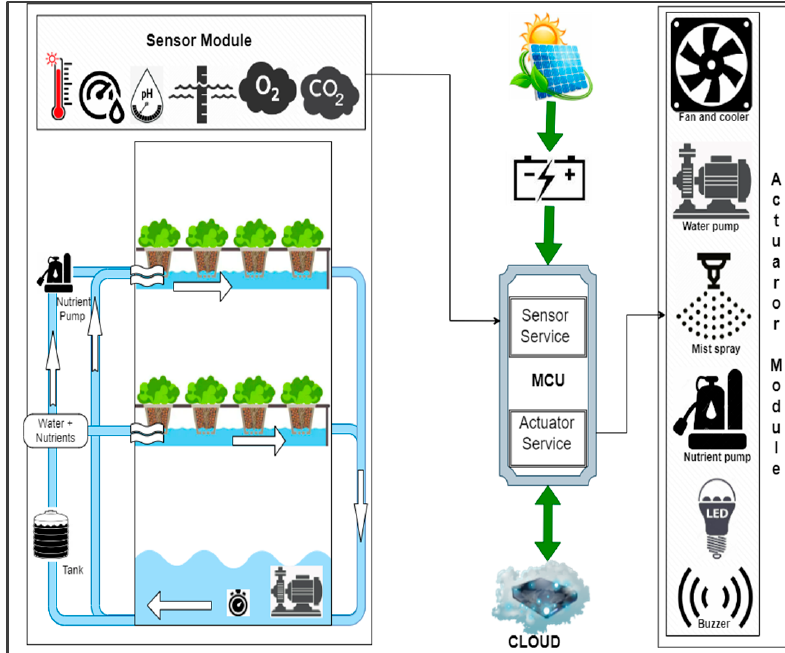
Figure 8. A smart hydroponic system.